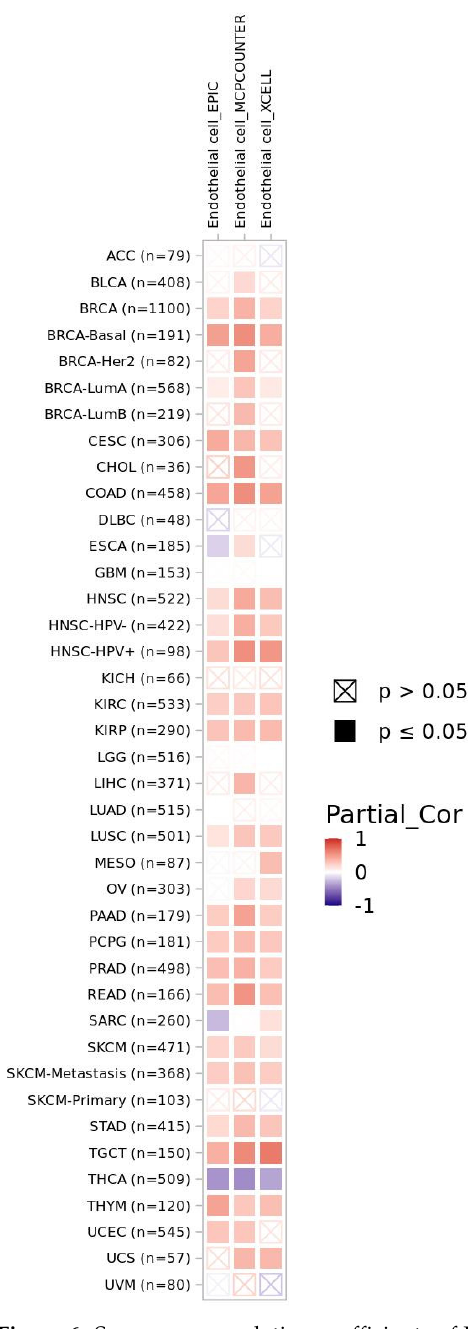
Figure 6. Spearman correlation coefficients of FAP expression and endothelial cell content within TCGA database. Analyses were performed with TIMER2.0 web resource. Color-filled boxes represent significant results ( p ≤ 0.05)—with red fillings indicating positive and blue fillings indicating negative correlation coefficients.